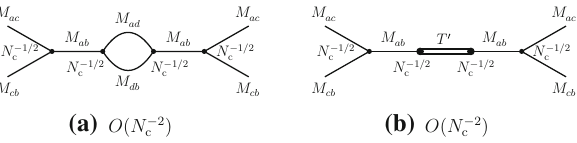
canbecreatedwithanyflavor,theresultingtwo-mesonand/or tetraquark states may belong to another class of cryptoexotic states. The corresponding mixings are described in Fig. 15. toexotic tetraquarks to two-meson